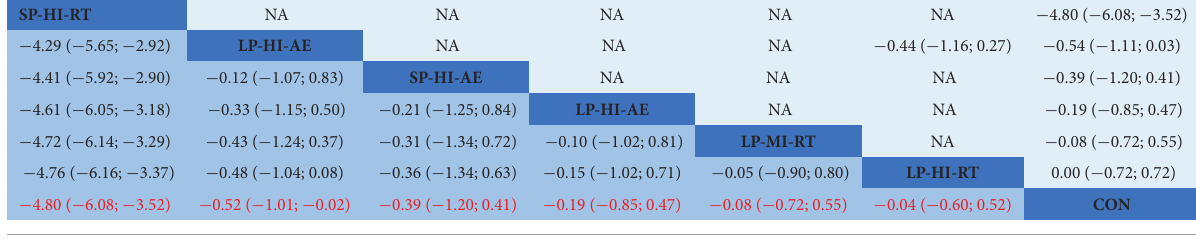
TABLE 5B Network meta-analysis of the efficacy of TUG. SP-HI-RT